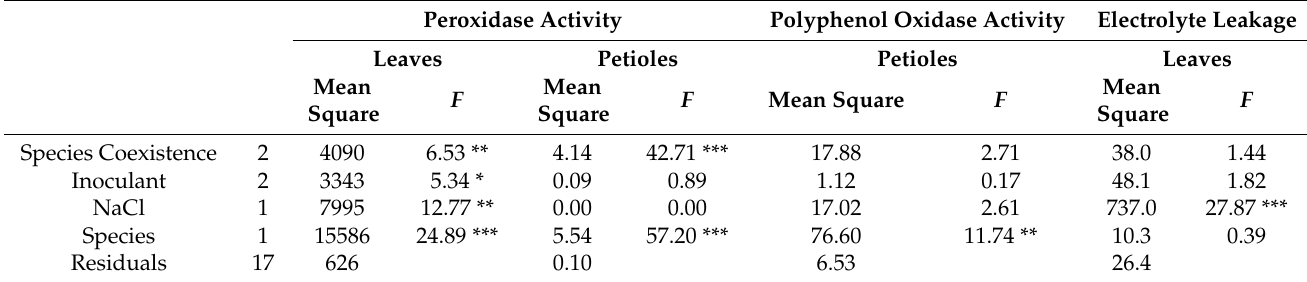
Figure 6. Polyphenol oxidase activity in leaves ( A ) and leaf petioles ( B ) of T. fragiferum and T. repens at the harvest. Data are the means from three replicates ± SE, the results are expressed on fresh mass basis. − i, without inoculant; +iTF, with inoculant isolated from T. fragiferum ; +iTR, with inoculant isolated from T. repens ; − Na, no NaCl added; +Na, NaCl up to 400 mM. Different letters indicate significant differences between the treatments ( p < 0.05). Table 13. ANOVA analysis of oxidative enzyme activity and tissue electrolyte